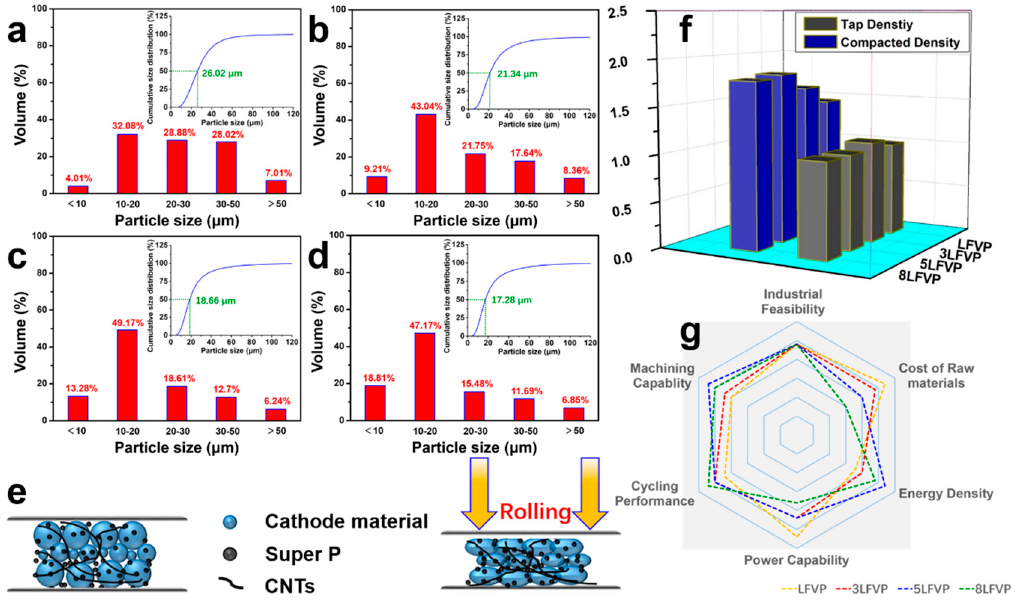
Figure 4. ( a – d ) Size distribution of xLFP·yLVP electrode materials, corresponding to LFVP, 3LFVP, 5LFVP, and 8LFVP, respectively; ( e ) illustration of the compaction process of electrode pieces; ( f ) comparison of xLFP·yLVP in terms of tap density for materials and compacted density for electrode pieces; ( g ) compressive evaluation of the series of xLFP·yLVP electrode materials.